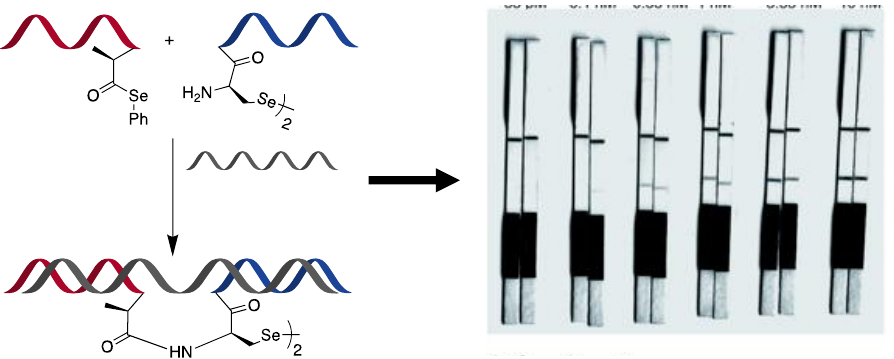
Figure 9. Illustration of the diselenide–selenoester ligation to a selenocysteine, templated by a target miR, used in a lateral flow strip assay as proposed in [112]. Published by the Royal Society of Chem- istry.